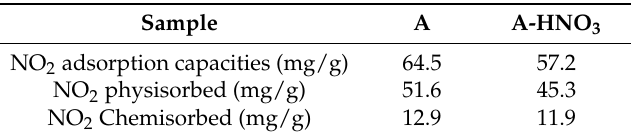
Table 3. Chemisorbed, physisorbed, and total amounts of NO 2 adsorbed at the surface of the activated carbons treated or not with HNO 3 .